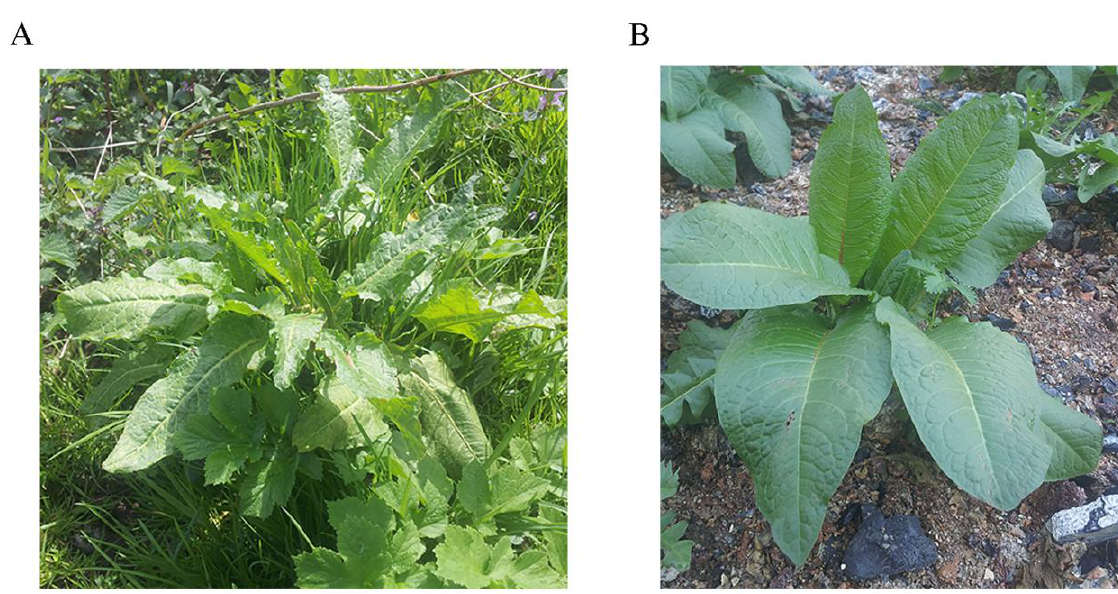
Figure 1. Individuals of R. obtusifolius grown on: (A) native habitat; (B) on ash amended